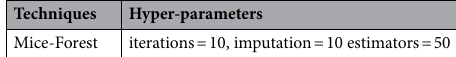
Table 3. Parameters of